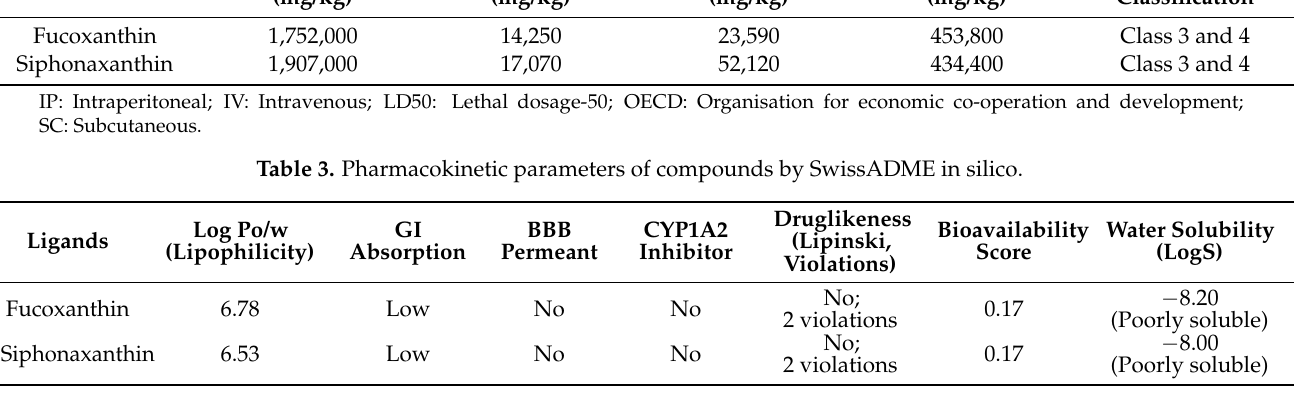
Table 2. Prediction of acute toxicity in silico by GUSAR in rodent models and chemical classification of compounds. Ligands